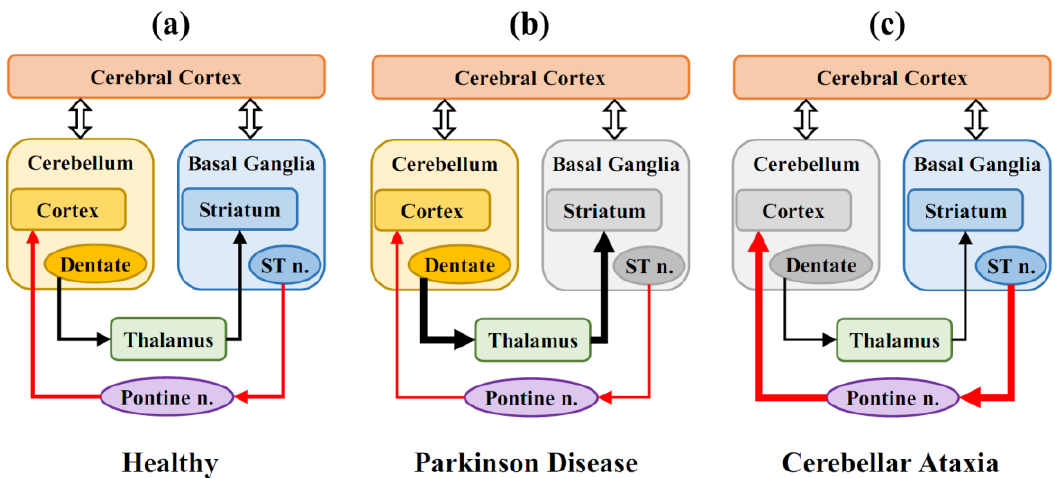
Figure 3. Subcortical compensatory networks. ( a ) Reciprocal interconnections between cerebellum and basal ganglia have been described in healthy conditions [116,117]. Panel ( b ) shows how the pathway from cerebellum to basal ganglia enhances its activity (thick black arrow) in Parkinson’s disease, to compensate the basal ganglia deficit [123]. Symmetrically, in ( c ), it is proposed that the pathway from basal ganglia to cerebellum (thick red arrow) may allow the former to compensate for cerebellar deficits in ataxia.